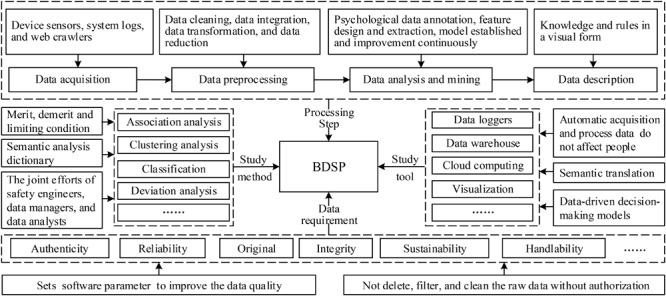
Framework of BDSP.